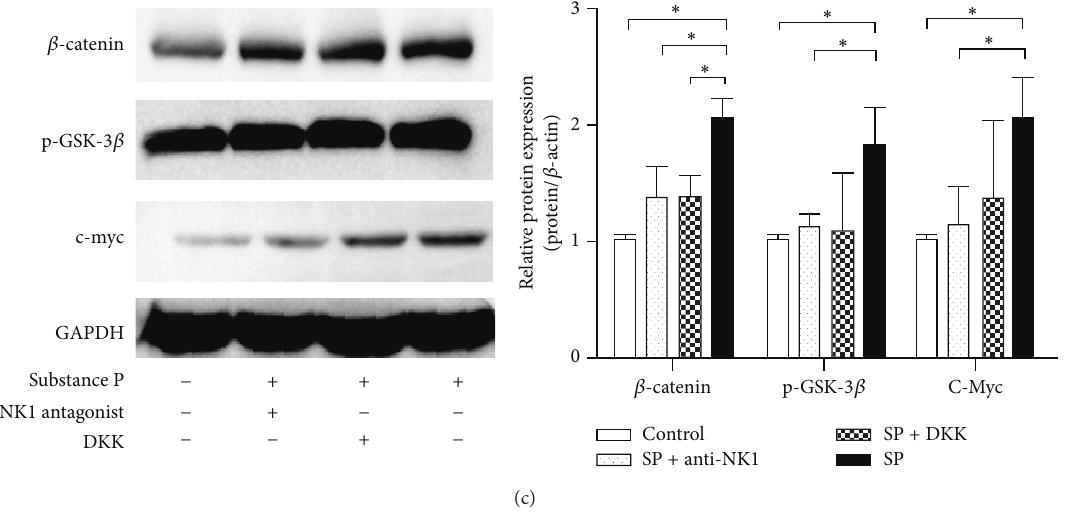
Figure 3: Effect of SP on Wnt-related molecules in BMSCs. The mRNA and protein levels of the Wnt pathway proteins 𝛽 -catenin, GSK- 3 𝛽 /p-GSK-3 𝛽 , cyclin D1, and c-myc were evaluated by qPCR and Western blot analysis in BMSCs. A significant activating effect of SP on Wnt signaling was observed after 12h (a). Various concentrations of SP (10 −8 , 10 −10 , and 10 −12 mol/L) upregulated the protein levels of Wnt pathway proteins (b). An NK-1 antagonist and the Wnt pathway inhibitor DKK1 both attenuated the activating effect of SP on Wnt signaling, indicating that the Wnt pathway mediates the effect of SP (c).